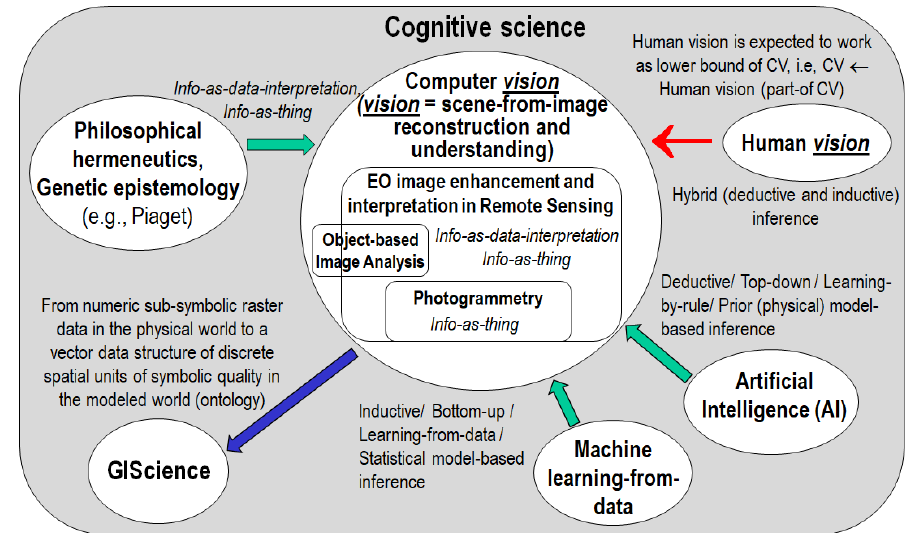
Figure 2. Multi-disciplinary cognitive science domain, adapted from [18,77 – 81], where it is postulated that ‘Human vision → computer vision (CV)’, where symbol ‘ → ’ denotes relationship part-of pointing from the supplier to the client, not to be confused with relationship subset-of , ‘ ⊃ ’, meaning